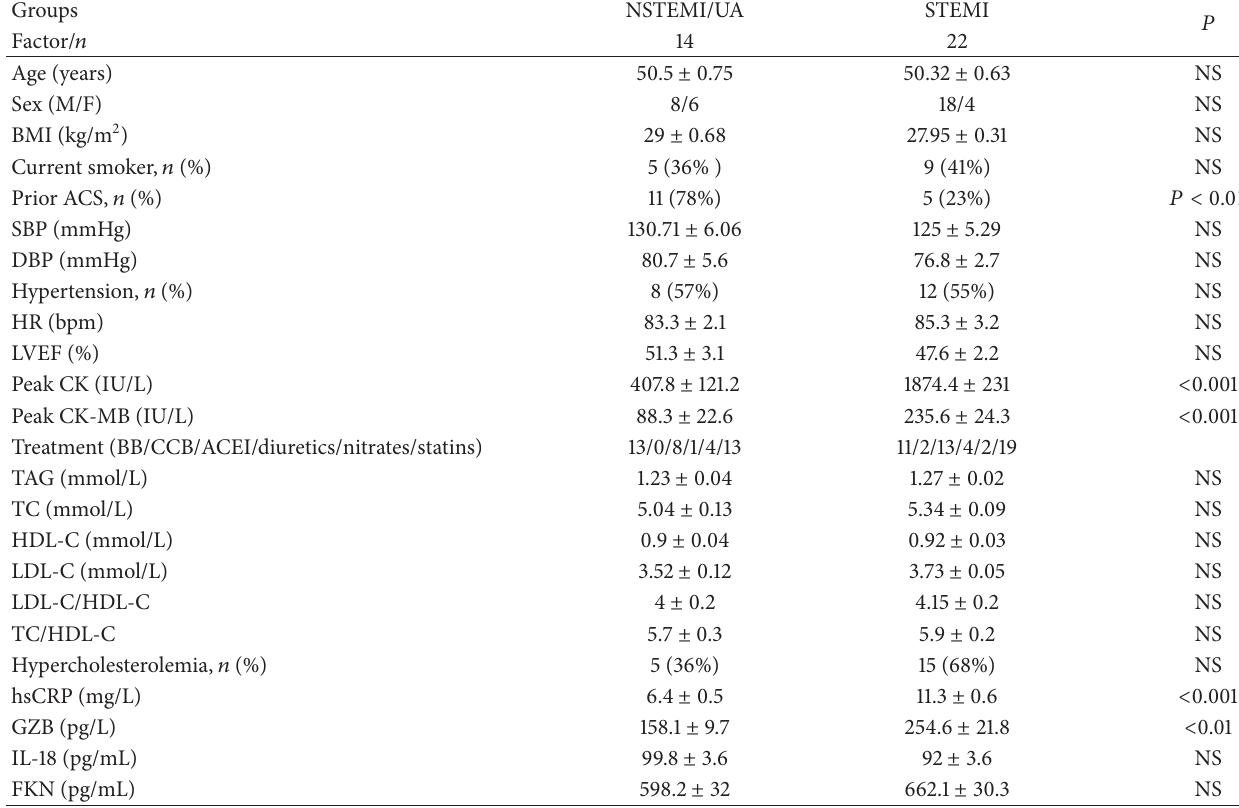
Table 2: Demographic data and biochemical parameters in STEMI and NSTEMI/UA